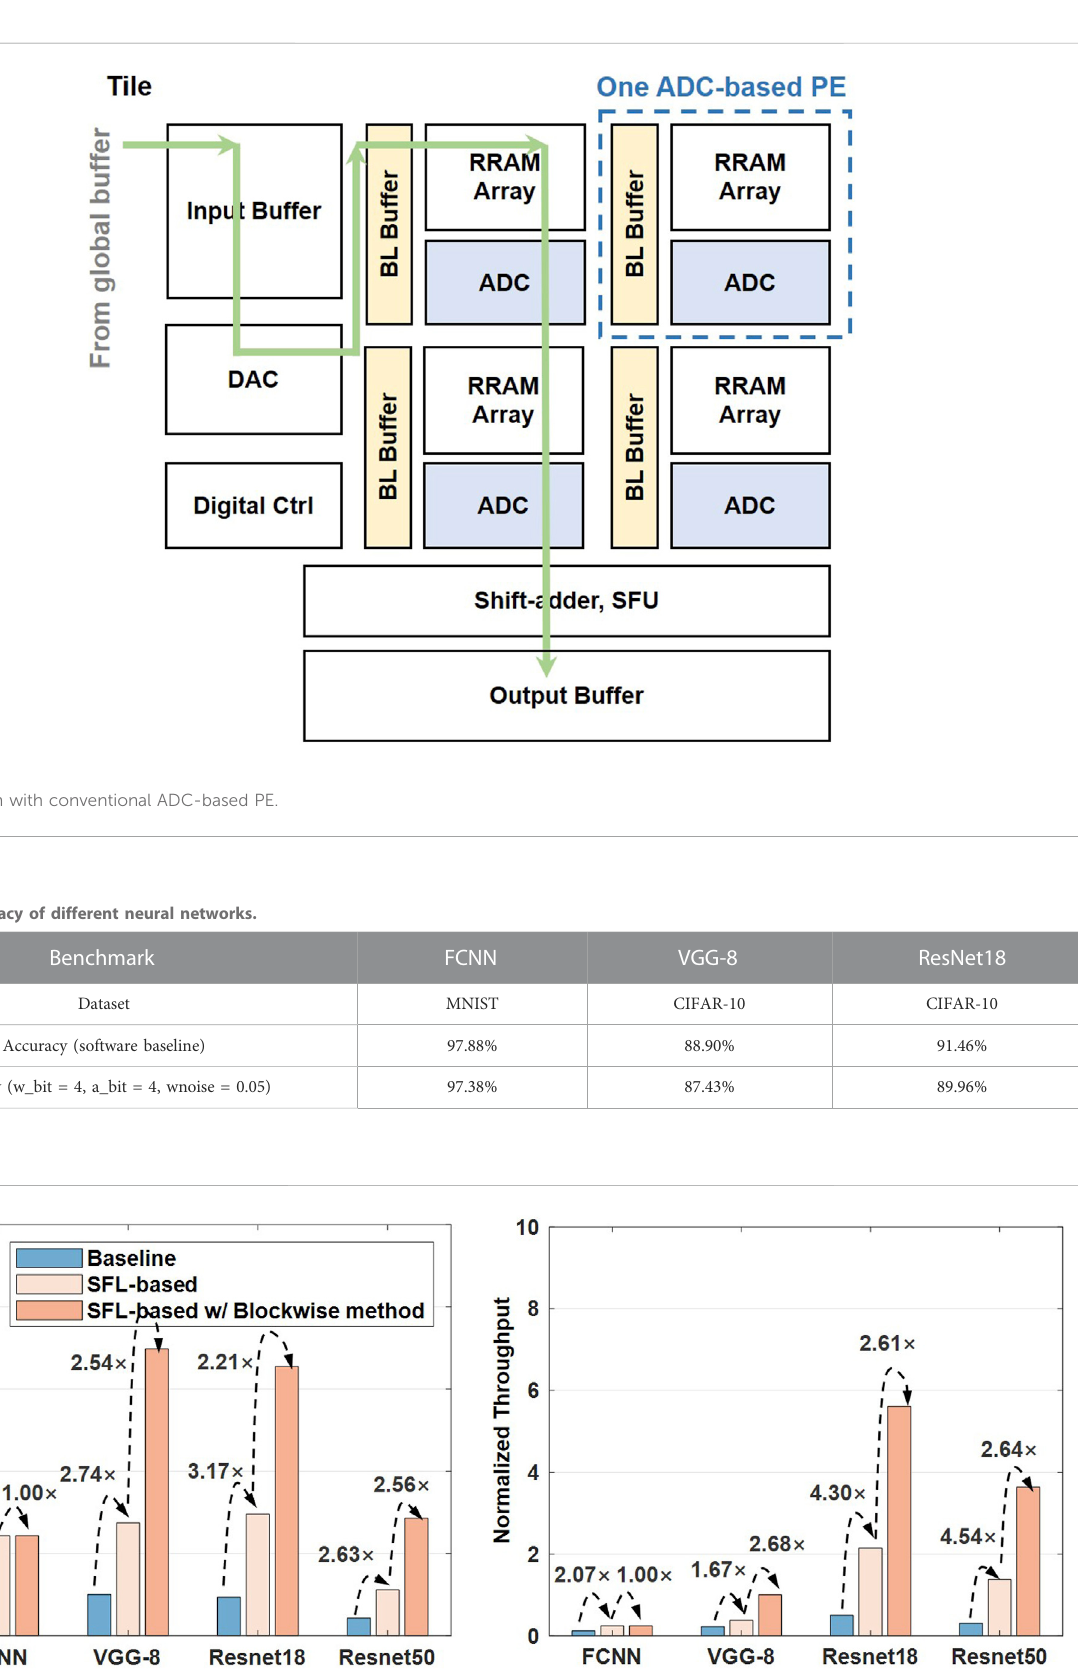
FIGURE 8 Performance benchmarks on different DNN models (4-bit weight/4-bit input con fi guration).